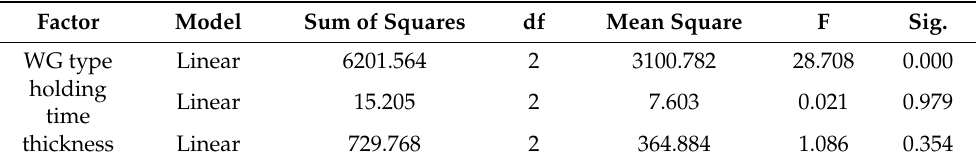
Table A1. ANOVA for the whiteness of the specimens.